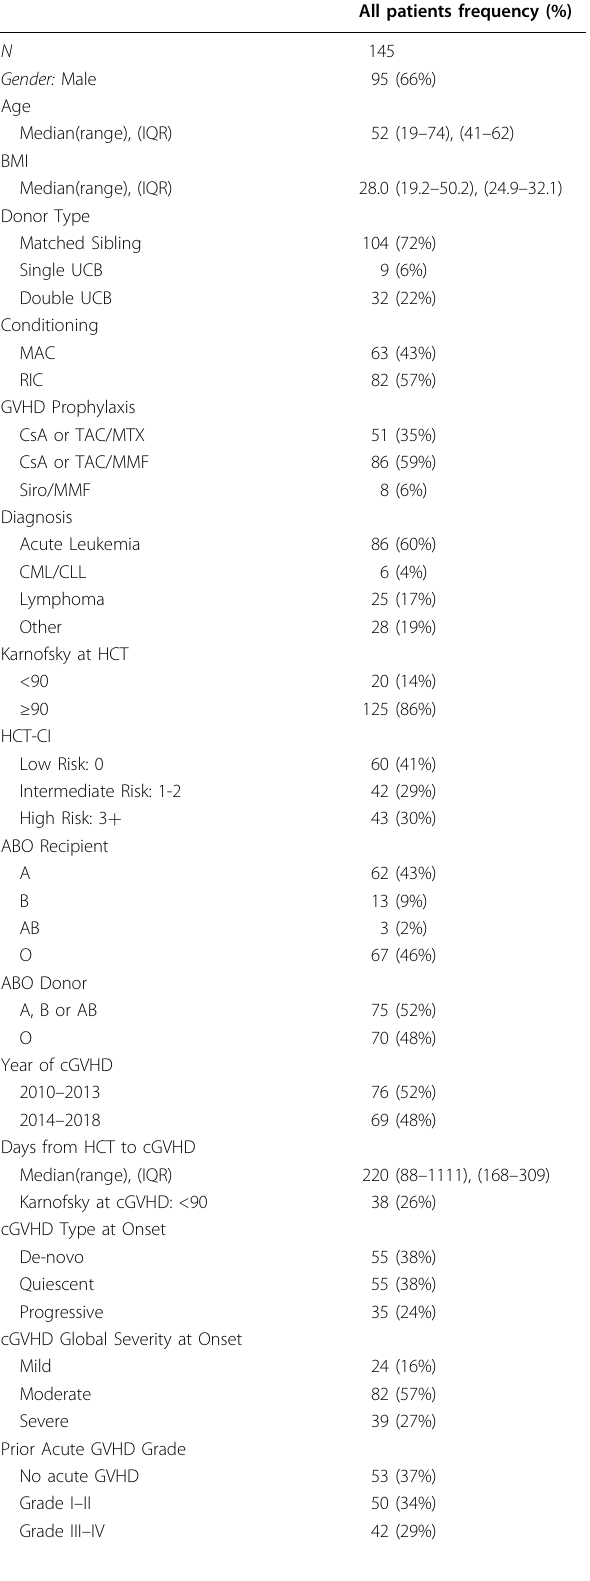
Table 1 Patient, disease and transplant